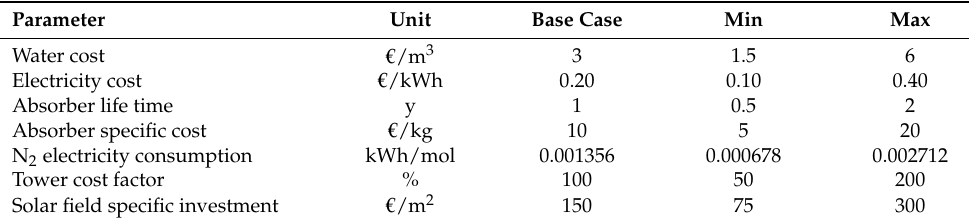
Table A3. List of ranges used for the economic parametric